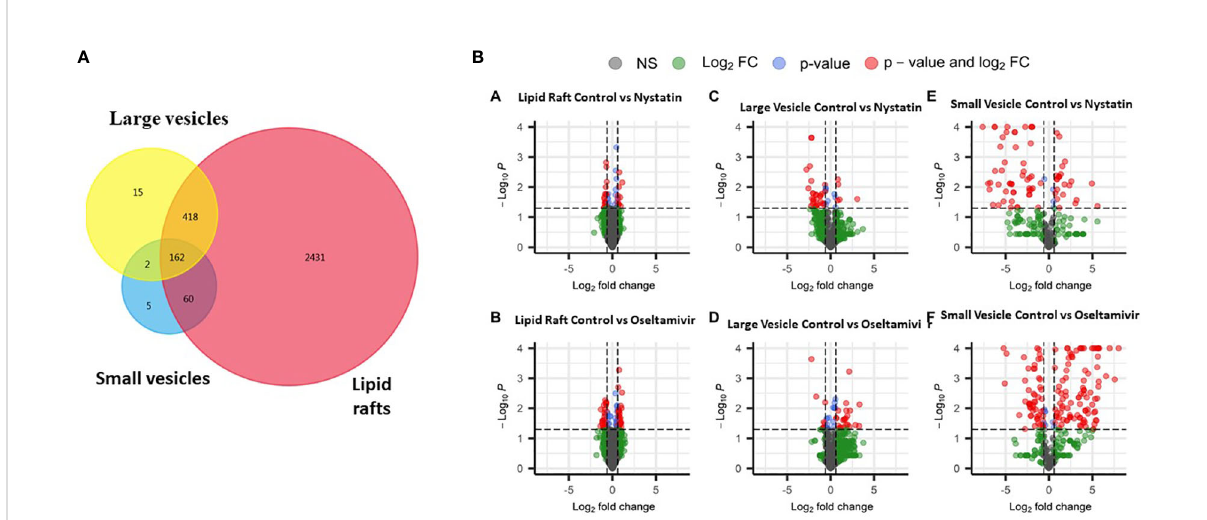
FIGURE 6 Proteomic comparison of rafts, LVs and SVs. (A) Venn diagram showing the distribution of proteins in three different components. (B) Volcano plots showing differentially expressed proteins between control and treatments with nystatin (27 m M) and oseltamivir (20 m M). Comparisons are shown in graphs a ’ (raft control vs nystatin); b ’ (raft control vs oseltamivir); c ’ (LVs control vs nystatin), d ’ (LVs control vs oseltamivir); e ’ (SVs control vs nystatin) and f ’ (SVs control vs oseltamivir). Volcano plots show – log10 P-values from the normalized proteomics data exported